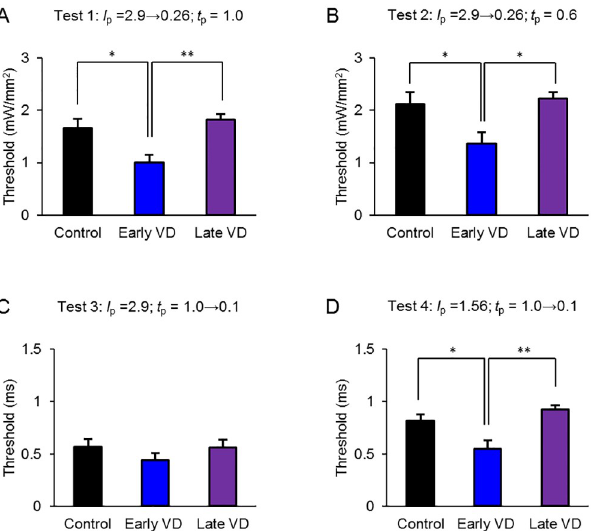
Fig 7. Comparison of the perceptual threshold. A , Summary of the thresholds by test 1, the control (n = 9), the early VD (n = 10) and the late VD (n = 8) groups, respectively from left to right: p = 0.012, the control vs. early VD; p = 0.75, the control vs. late VD and p = 0.0026, early VD vs. late VD. B , Similar to A, but by test 2: p = 0.027, the control vs. early VD; p = 0.93, the control vs. late VD and p = 0.014, early VD vs. late VD. C , Similar to A, but by test 3: p = 0.41, the control vs. early VD; p = 0.99, the control vs. late VD and p = 0.45, early VD vs. late VD. D , Similar to A, but by test 4: p = 0.021, the control vs. early VD; p = 0.51, the control vs. late VD and p = 0.0018, early VD vs. late VD. � , p < 0.05, �� , p < 0.01, one-way ANOVA Turkey-Kramer post hoc